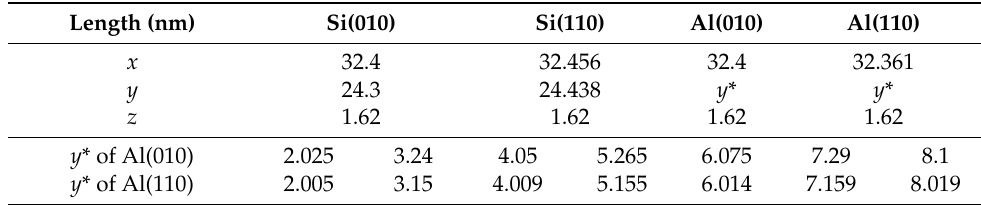
Table 2. Lengths of the simulation models in Cartesian coordinates. The variable y * denotes the length of the Al nanofilm along the y -direction. The numbers in the brackets denote the crystallographic orientation with respect to the interface plane of each